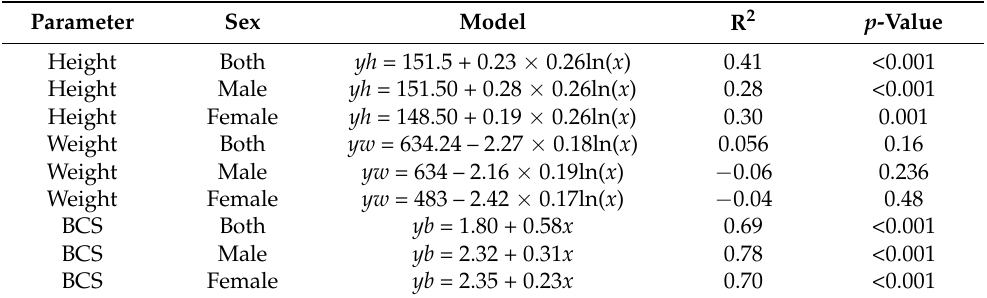
The model indicates the relationship between age ( x ) and growth parameters (height ( yh ), weight ( yw ), and body condition score ( yb ), ln = natural logarithm) in males, females, and both